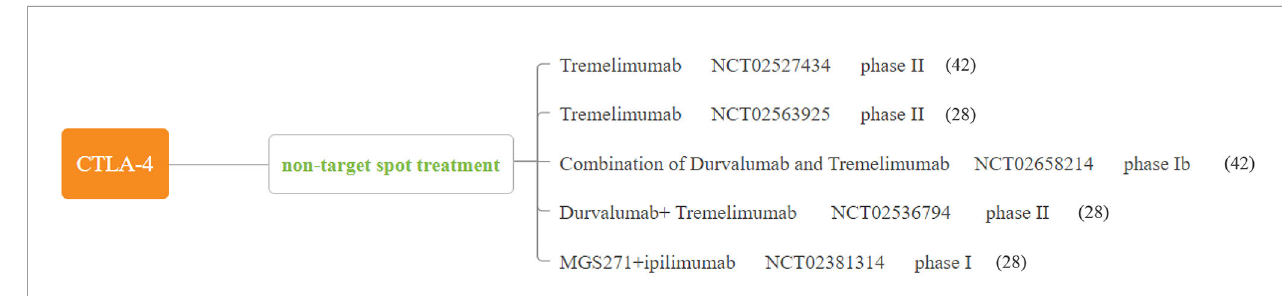
FIGURE 1 | Major published clinical trials using CTLA-4 inhibitors in